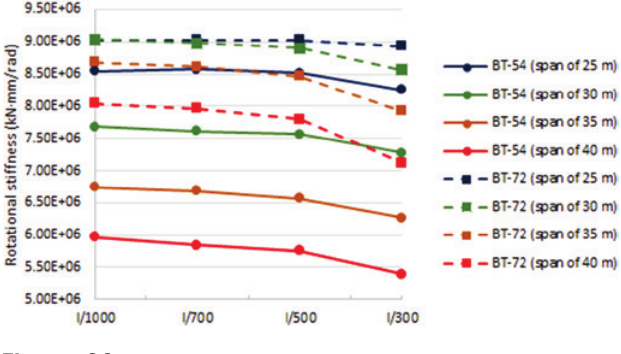
Effective stiffness around Y × mid-span eccentricity (limit situation)